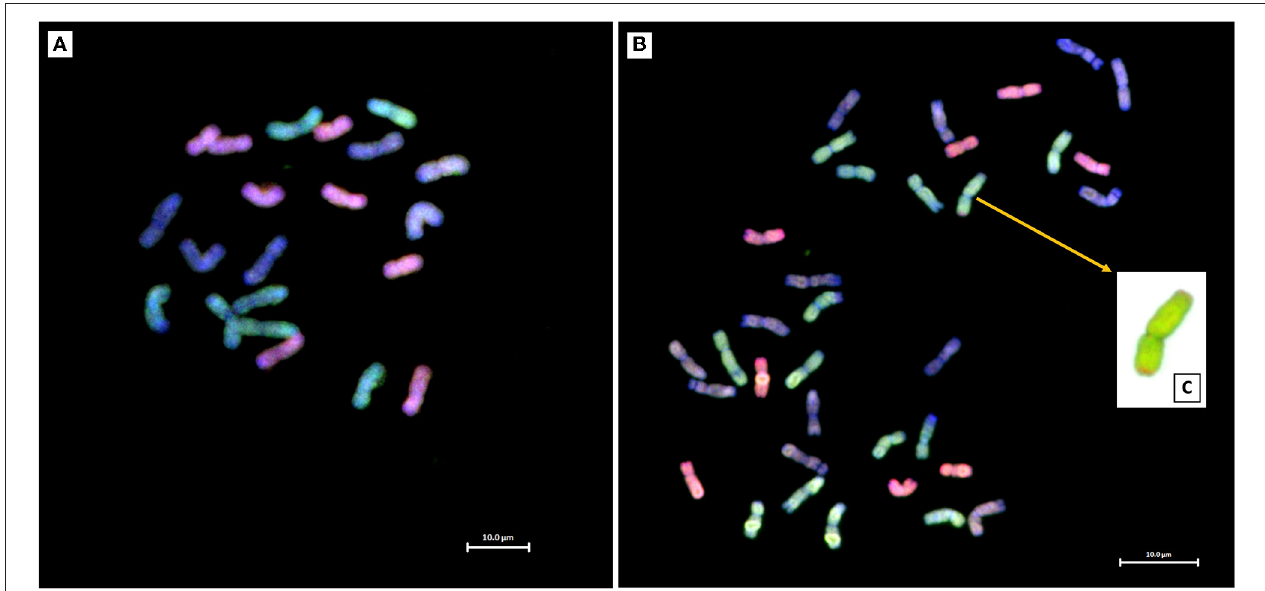
FIGURE 2 | Mc-GISH of root-tip metaphase spreads of (A) the F 1 and (B) F 1 T plants revealing the presence of a telomeric A-d chromosome translocation (C) in the F 1 T plant (A-genome, green; B-genome, blue/purple; D-genome, red).